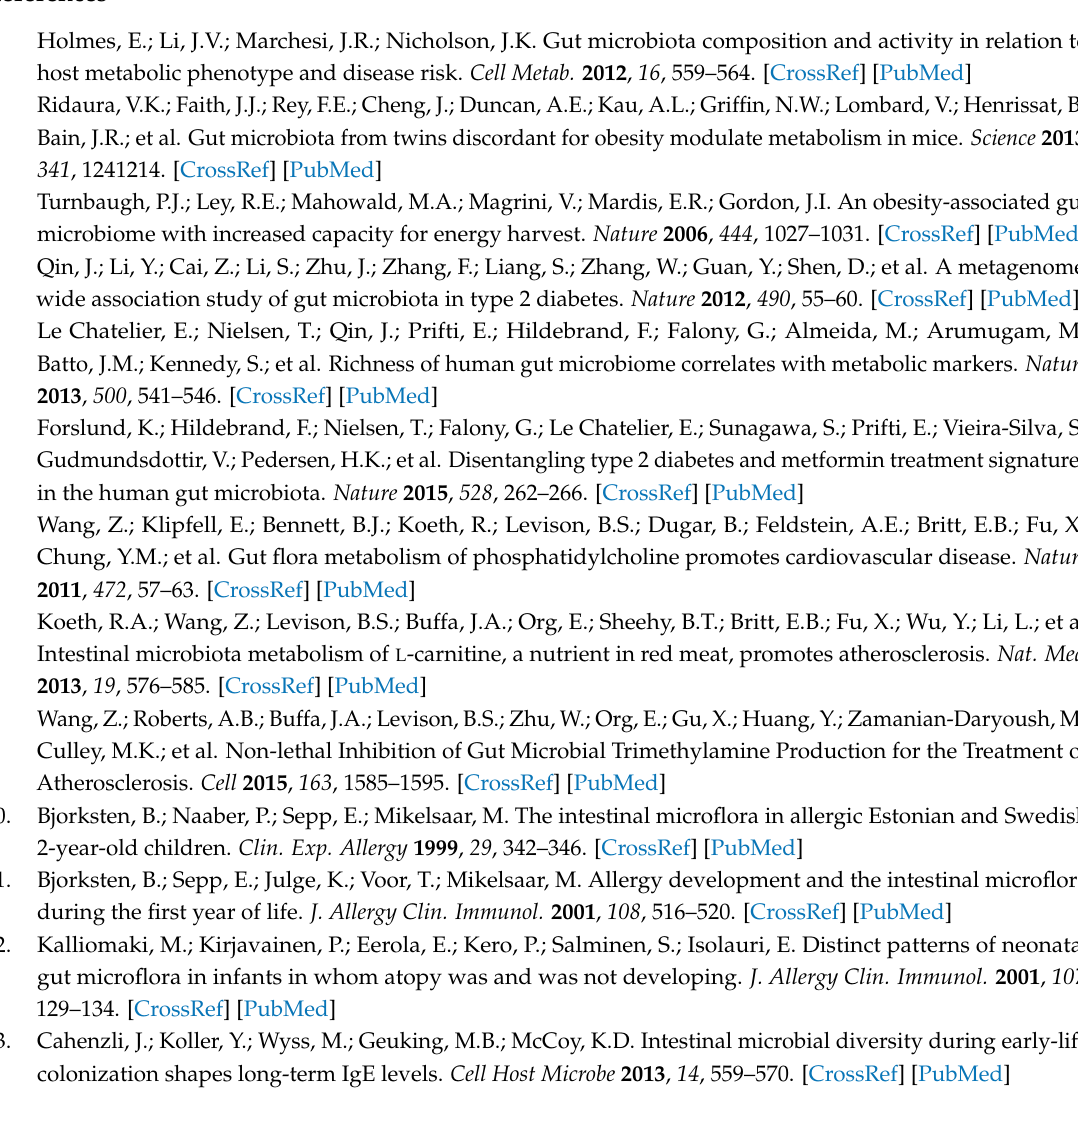
Figure S1: Overview of the sampling points, Figure S2: The number of detected luminal metabolites in each part of the gastrointestinal tract of SPF and GF mice, Figure S3: The composition of gastrointestinal luminal microbiota in SPF mice, Table S1: Different concentration of gastrointestinal luminal metabolites between SPF and GF mice, Table S2: The characteristic gastrointestinal luminal metabolites on each part of intestinal